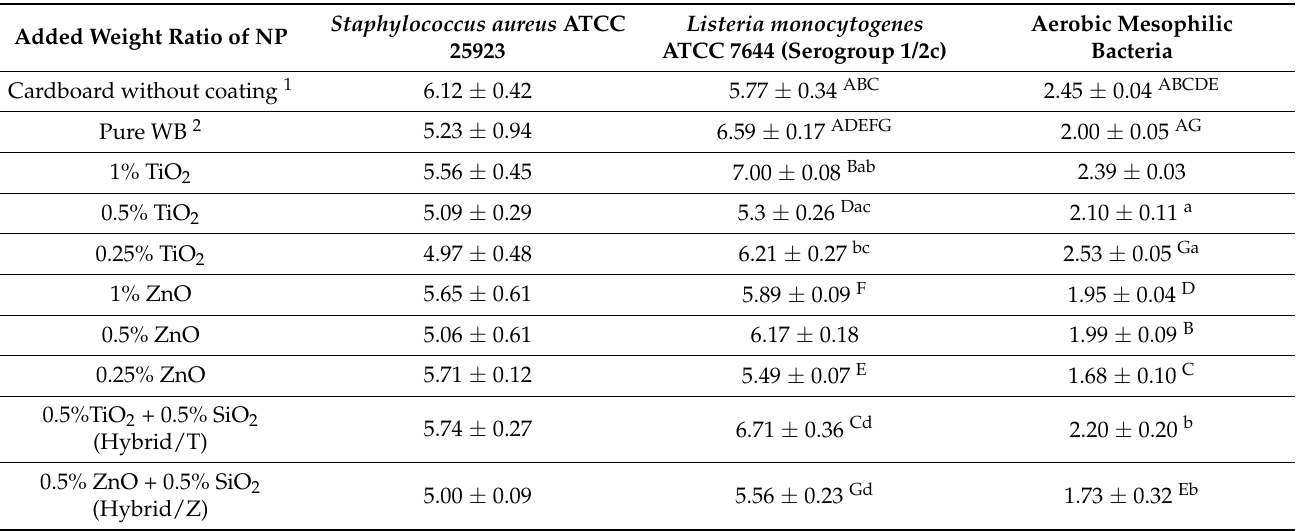
Table 3. Results of testing the growth inhibition of artificially inoculated pathogens and environmen- tally contaminated cardboard samples by nanocomposite